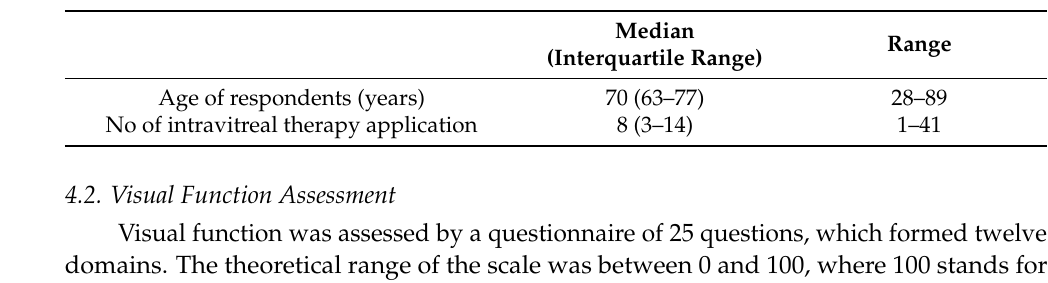
Table 2. Age of the respondents and ordinal number of current intravitreal therapy application.